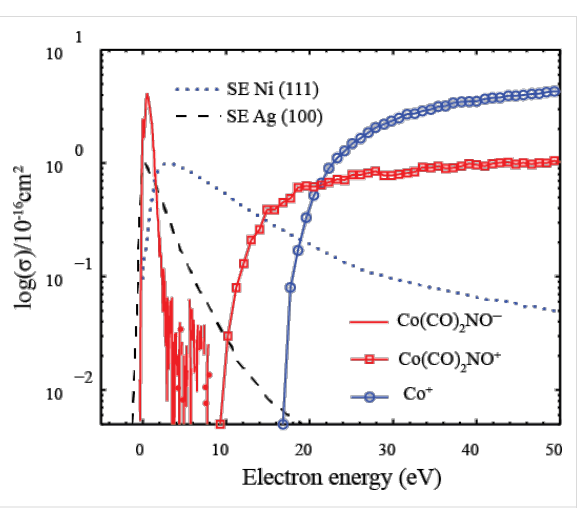
Figure 20: Predicted relative effective damage yield for single CO loss through DEA (red solid line), for single CO loss through DI (red open squares) and for the formation of Co + through DI (blue open circles). Damage yields are derived from the product of the respective partial cross sections and the normalized measured SE yields for (a) Ni(111) and (b) Ag(100). The cross sections are adapted from [10] and the SE yields for Ni(111) and Ag(100) from [6] and [9],